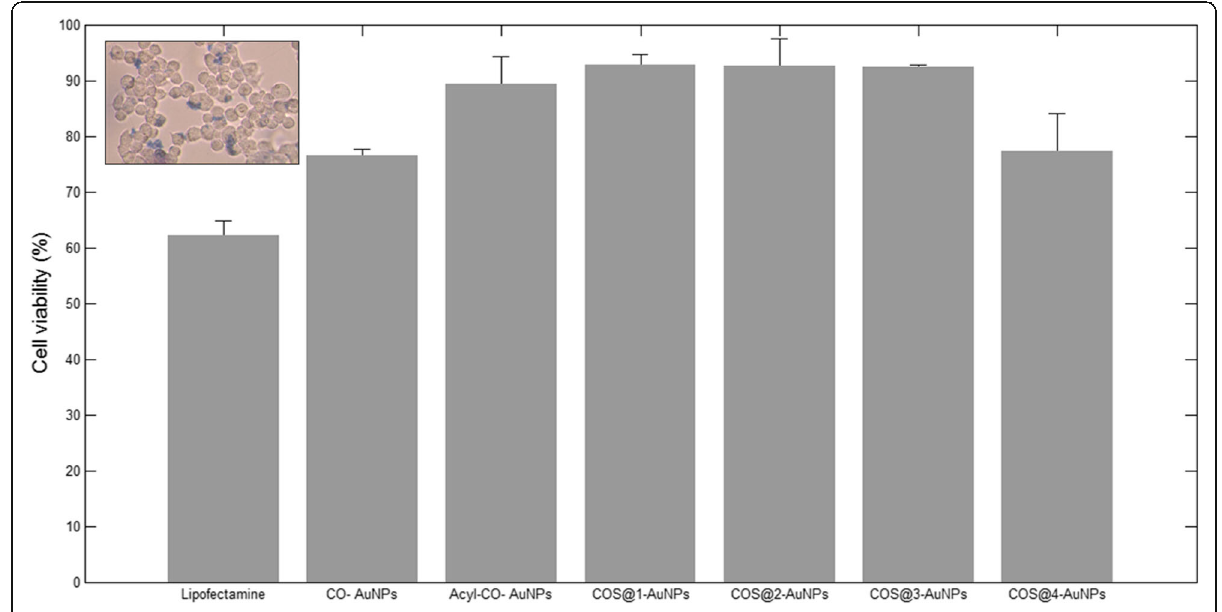
Fig. 11 Cell viability percentages obtained with the different nanocomplexes (pSV- β -Gal and pIRES2-EGFP test). HEK-293